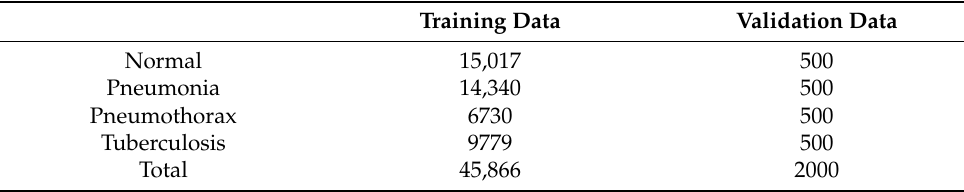
Table 2. SCH training dataset.